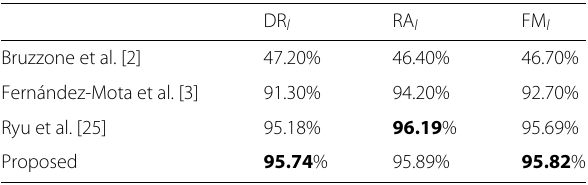
Table 4 Experimental results on the George Washington dataset